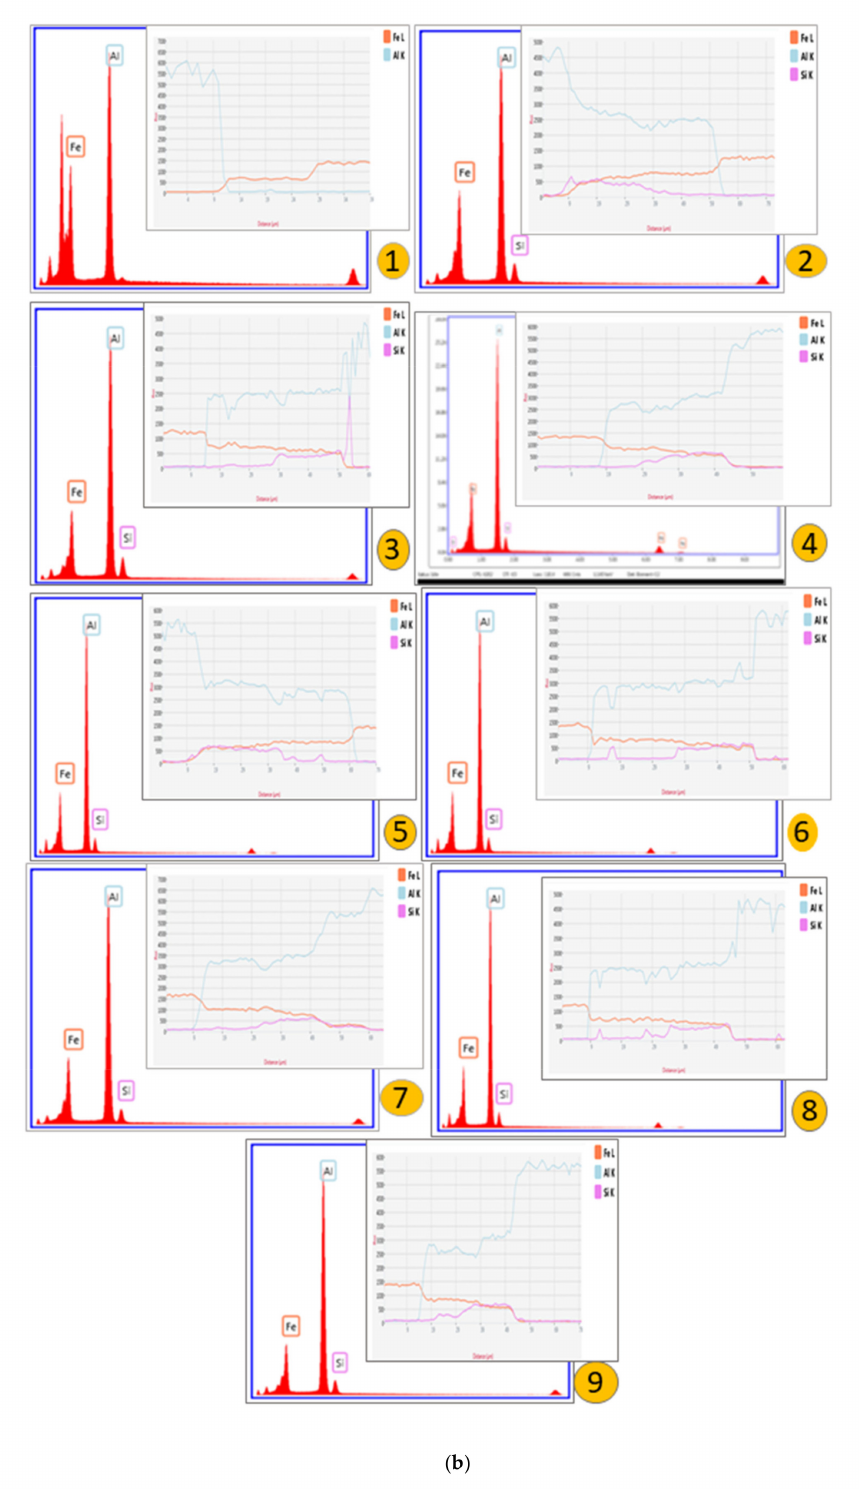
Figure 6. ( a ) SEM micrographs and EDS analysis of the interface of the aluminum/steel bimetallic composite (for all experiments). ( b ) SEM elemental percentage variation of the interface of the aluminum/steel bimetallic composite (for all